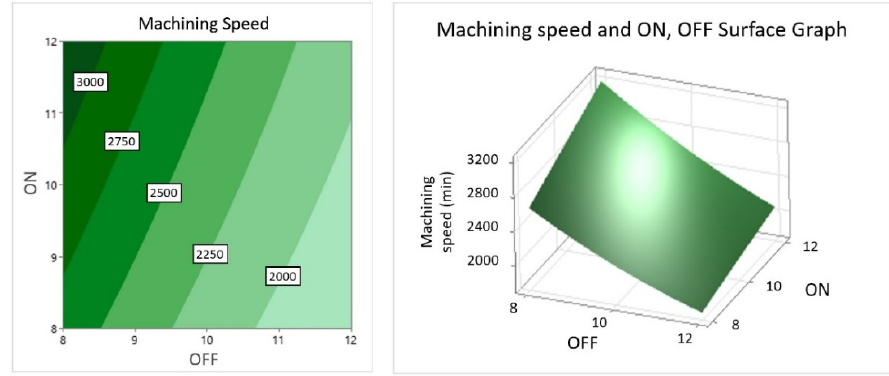
Figure 7. 2D contour and 3D surface plots for machining speed.